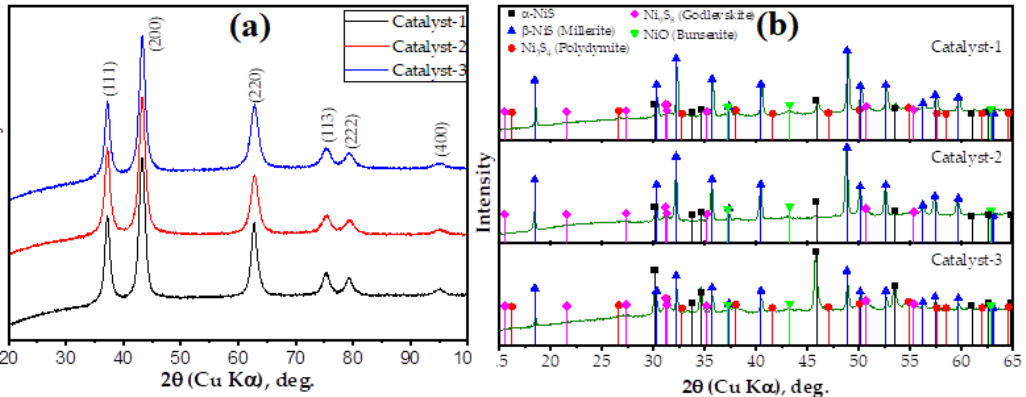
Figure 3. XRD patterns of ( a ) the fresh nickel oxide - based catalysts and ( b ) the solid products obtained after the upgrading of oil using these catalysts. In ( a ), the Miller indexes corresponding to the NiO bunsenite phase are signed, whereas in ( b ), reflexes attributed to the various crystalline phases are labelled by the colored